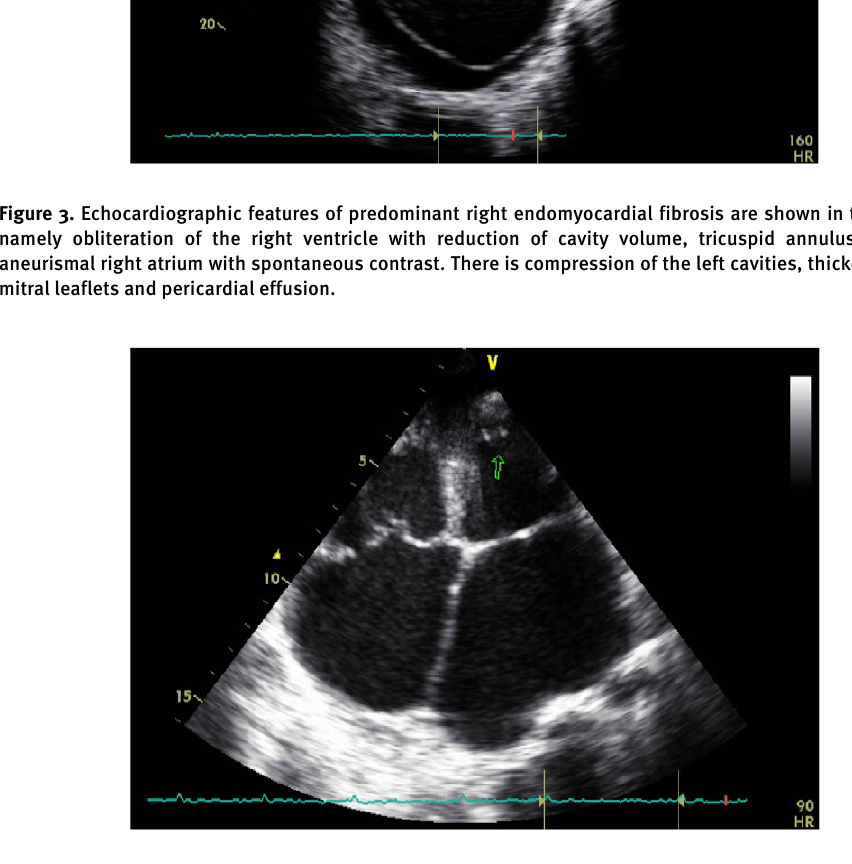
Figure 4. The main echocardiographic signs of bilateral endomyocardial fibrosis are seen in this photograph: small ventricles with large atria, filling defect in the apices suggesting thrombus on the left ventricle (arrow). Differential